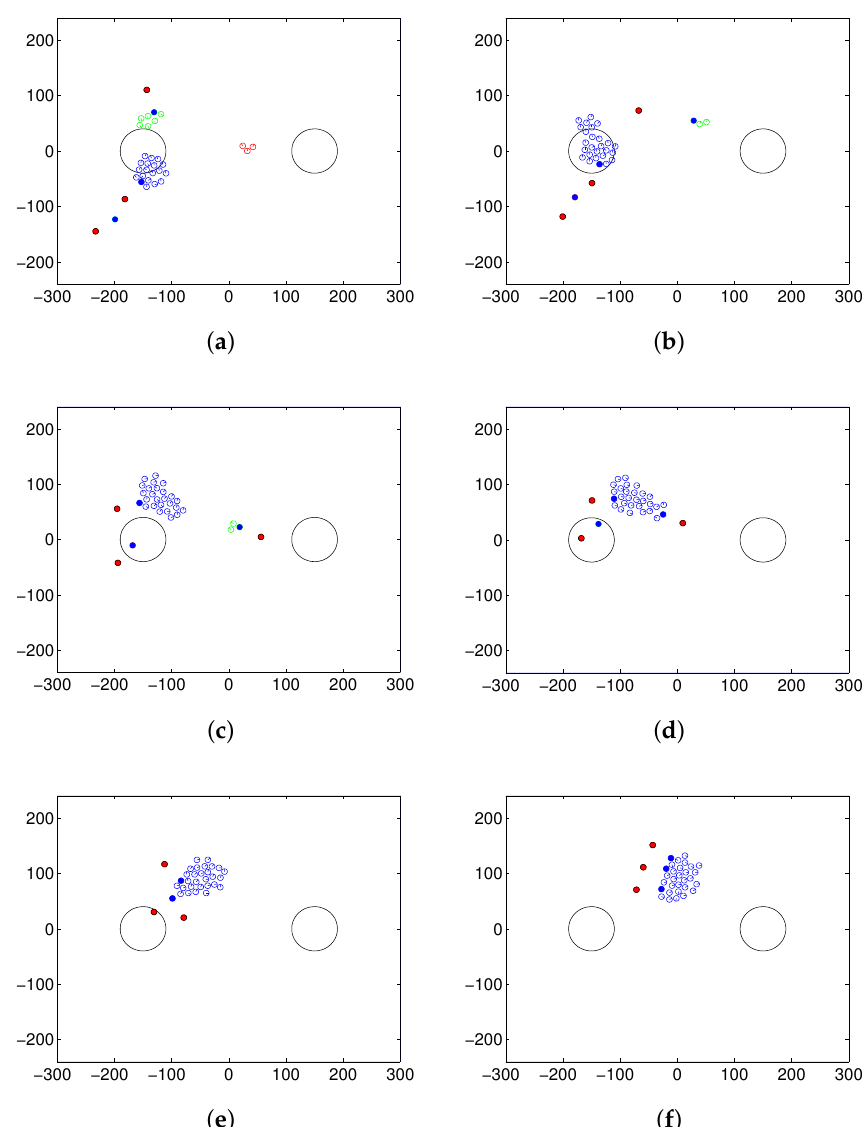
Figure 6. Snapshot of the simulation for performing collecting behavior over four scattered flocks: ( a ) patrolling and collecting, ( b – d ) herding and collecting and ( e , f ) herding after collecting all the scattered